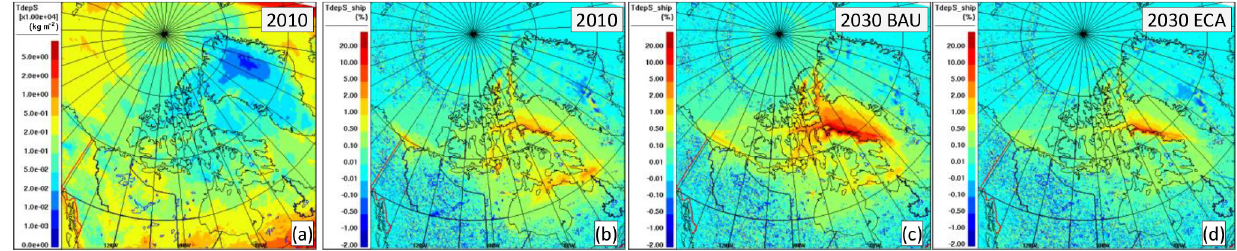
Figure 15. (a) Total sulfur deposition over the July–August–September period (accumulated) for the base case (2010); (b) Arctic shipping contribution at current (2010) level; (c) the same as in (b) for the 2030 BAU scenario; (d) the same as in (b) for the 2030 ECA scenario.